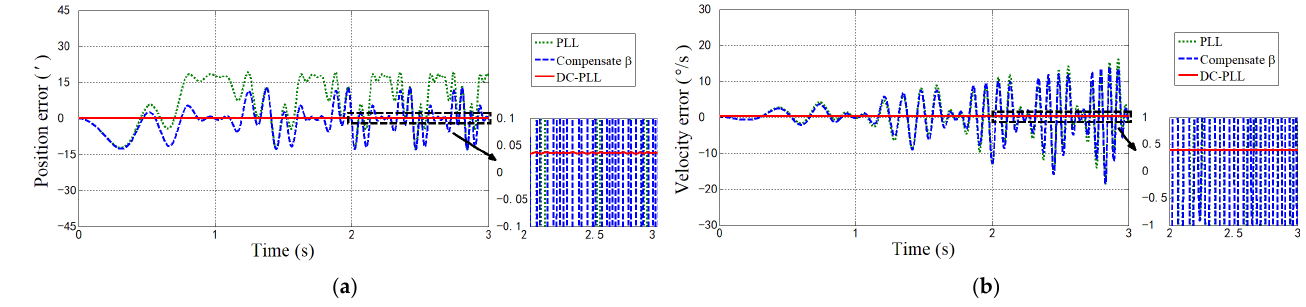
Figure 9. Demodulation errors at fixed acceleration in simulation. ( a ) Position estimation error; ( b ) velocity estimation error.